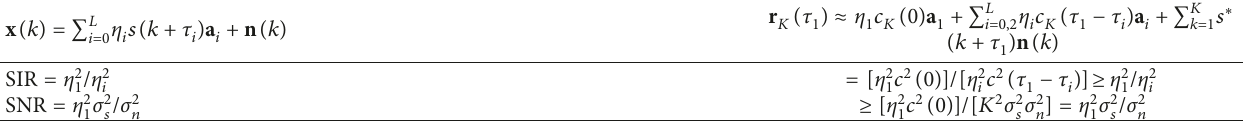
Table 1: The comparison of SIR and SNR.